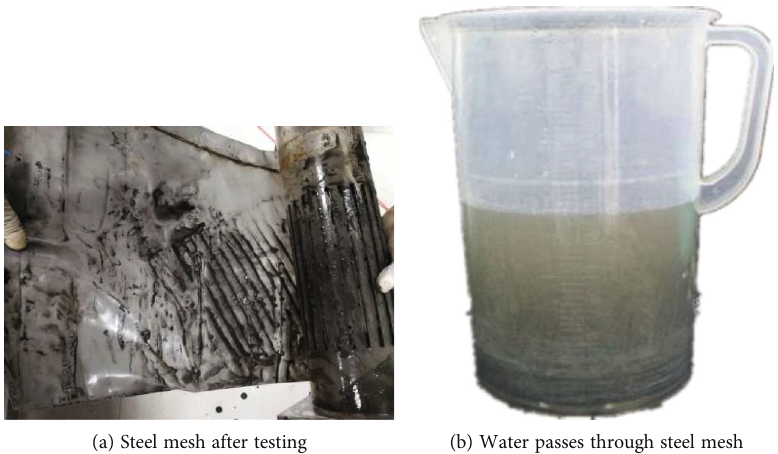
Figure 22: The mixture reaches the periphery of steel